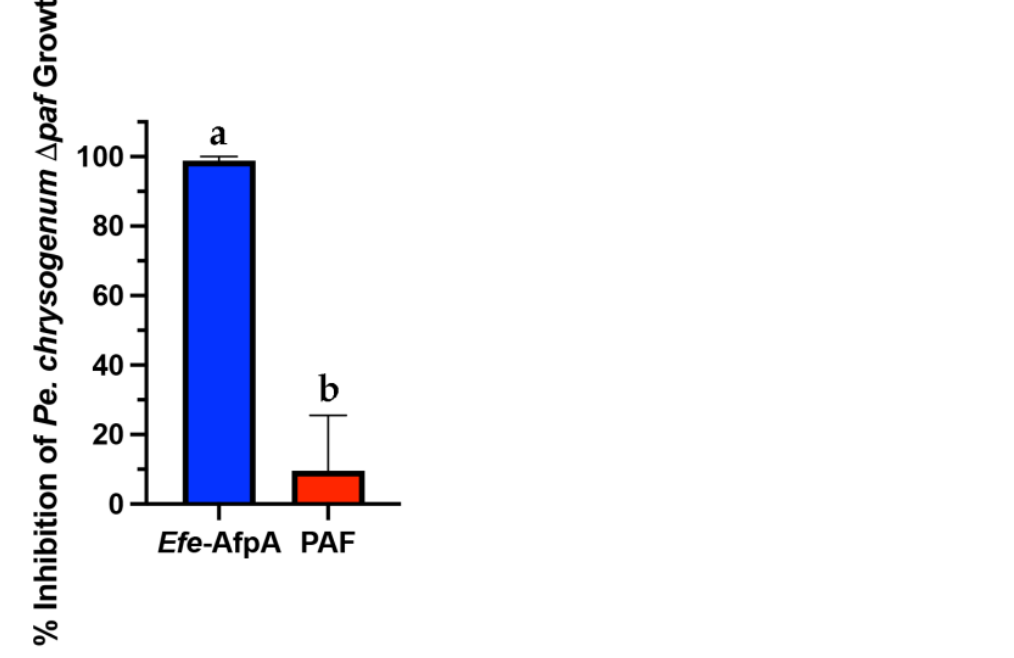
Figure 2. Comparison of activity of Efe -AfpA and PAF against Pe . chrysogenum ∆ paf conidial growth. Five µ g mL − 1 of either Efe -AfpA or PAF was assayed for activity against 1 × 10 4 conidia mL − 1 . The data presented are the means and standard deviations of three replicates. Columns with different letters indicate a significant difference in activity ( p ≤ 0.05, one-way ANOVA).